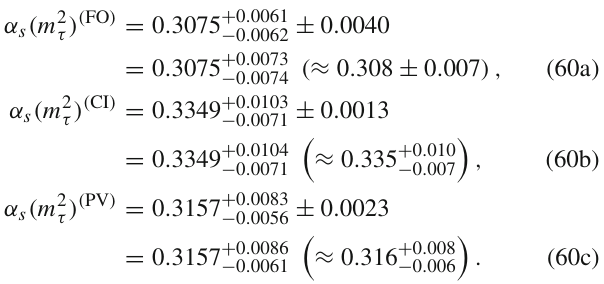
Table 5 (and of (cid:12) O 8 (cid:13) V + A in Table 4), in the PV and CIPT approaches, exists due to the instability of these extracted condensates when the renormalization scale parameter is varied from κ = 1 to κ = 0 . 5. This indicates that the RGE-running of the pQCD running coupling a (μ 2 ) along the contour μ 2 = 0 . 5 σ m exp ( i φ) (where 0 . 5 σ m ≈ 1 . 4 GeV 2 is low) is unreliable, due to the vicinity of the unphysical Landau singu- larities of the pQCD coupling at such low values of | μ 2 | . We note that in the PV approach, the polynomial correction part Eq. (47) is treated as in the CIPT approach when integrated along the